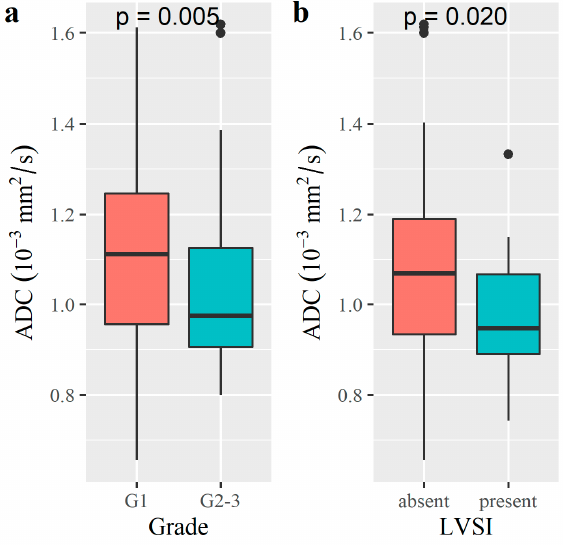
Figure 5. Boxplots of findings with representative significant differences ( p < 0.05) of ADC in tumor grade ( a ) and LVSI ( b ).